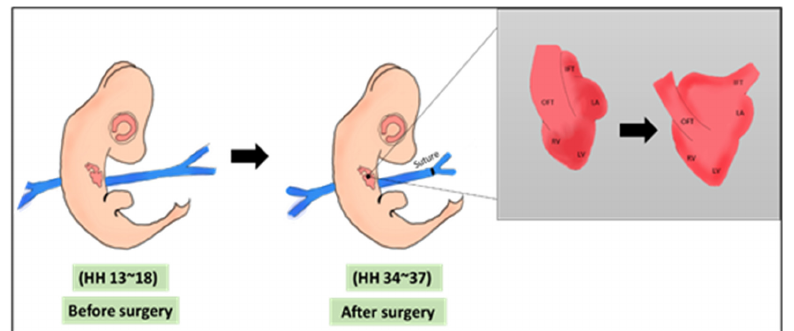
Figure 2. a schematic showing the VVL surgery. The surgery is done on HH 13–18 where a suture is banded around one of the vitelline veins. The main morphological output of VVL is the defected cardiac looping [45]. OFT: outflow tract, IFT: inflow tract, LA: left atrium, RV: right atrium, LV: left ventricle, RV: right ventricle, HH: Hamburger &